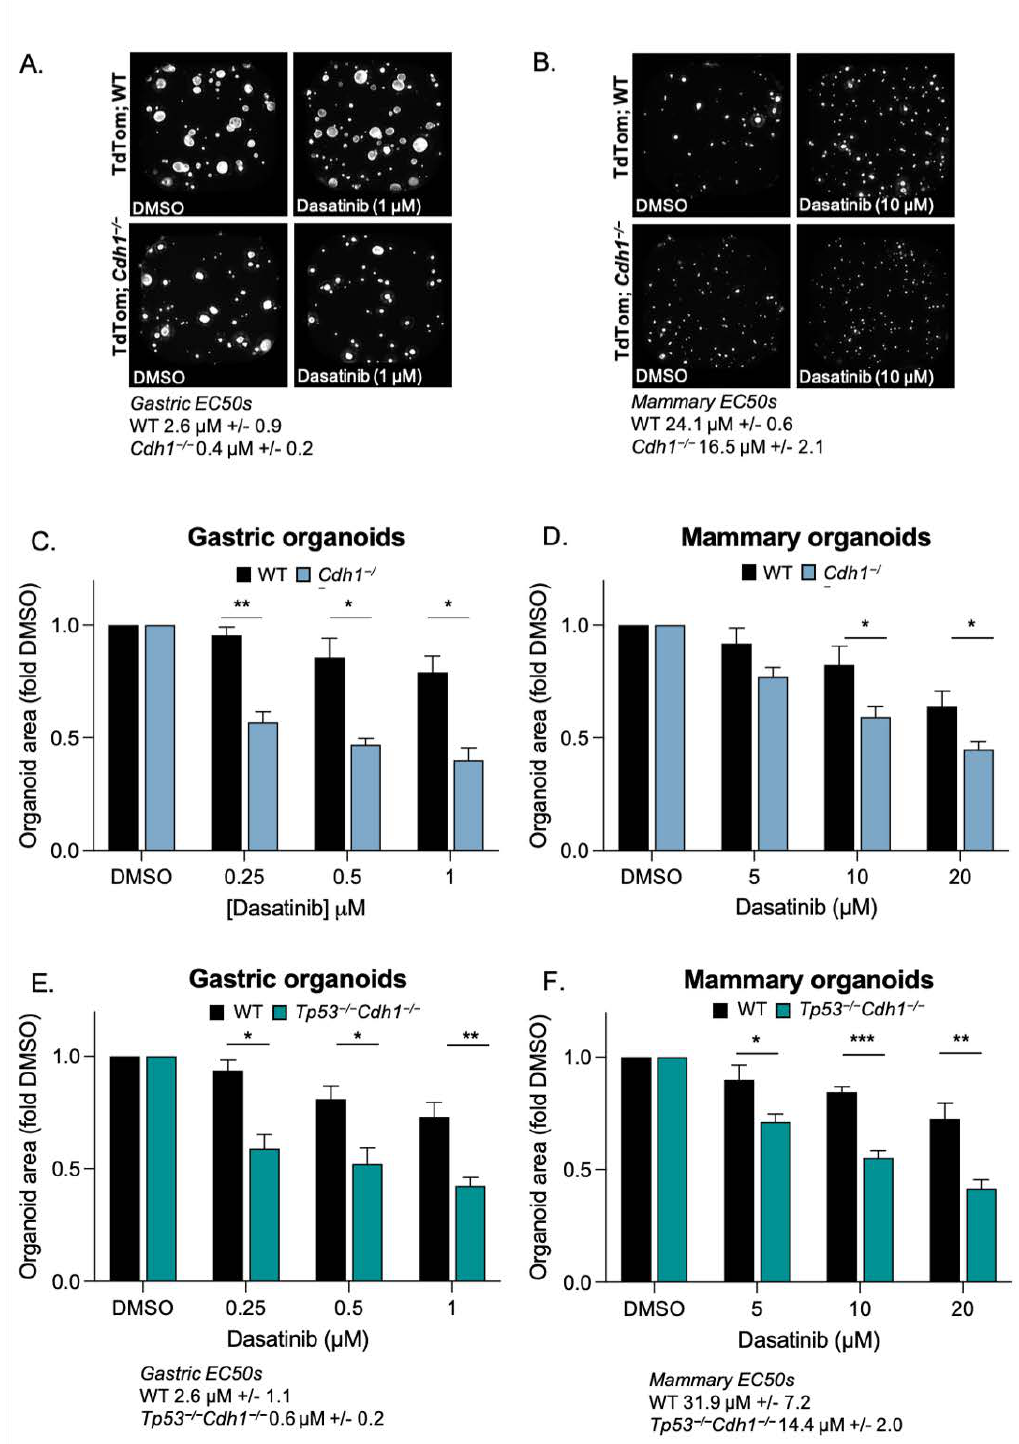
Figure 4. Mouse-derived organoids containing Cdh1 − / − cells are more sensitive to the growth inhibiting effects of dasatinib. Representative photos of WT and Cdh1 − / − gastric ( A ) and mammary ( B ) organoids after 48 h treatment with DMSO or dasatinib. Bar graphs showing relative area of DMSO or dasatinib treated gastric ( C ) or mammary ( D ) organoids. Bar graphs showing relative area of DMSO or dasatinib treated WT or Tp53 − / − Cdh1 − / − gastric ( E ) and mammary ( F ) organoids. (For all graphs, error bars = SEM; * p < 0.05, ** p < 0.01 and *** p <0.001; n ≥ 3 independent biological replicates; unpaired two-sided t